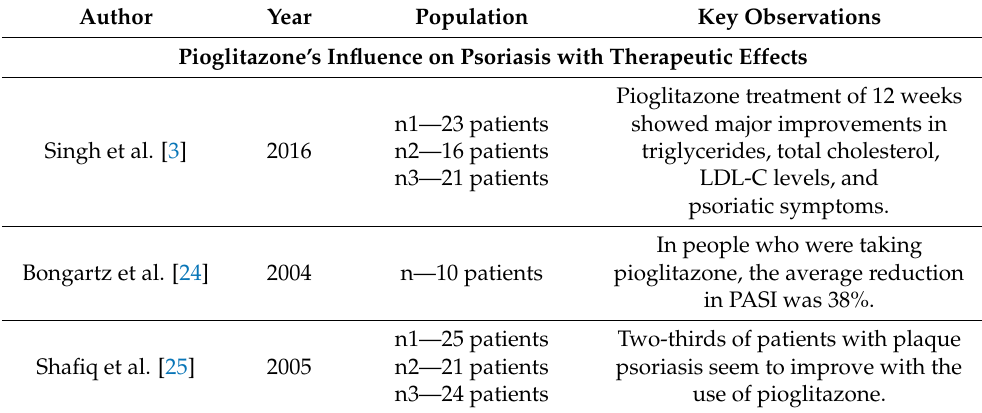
Table 8. Summary of the studies on pioglitazone’s influence on psoriasis with therapeutic